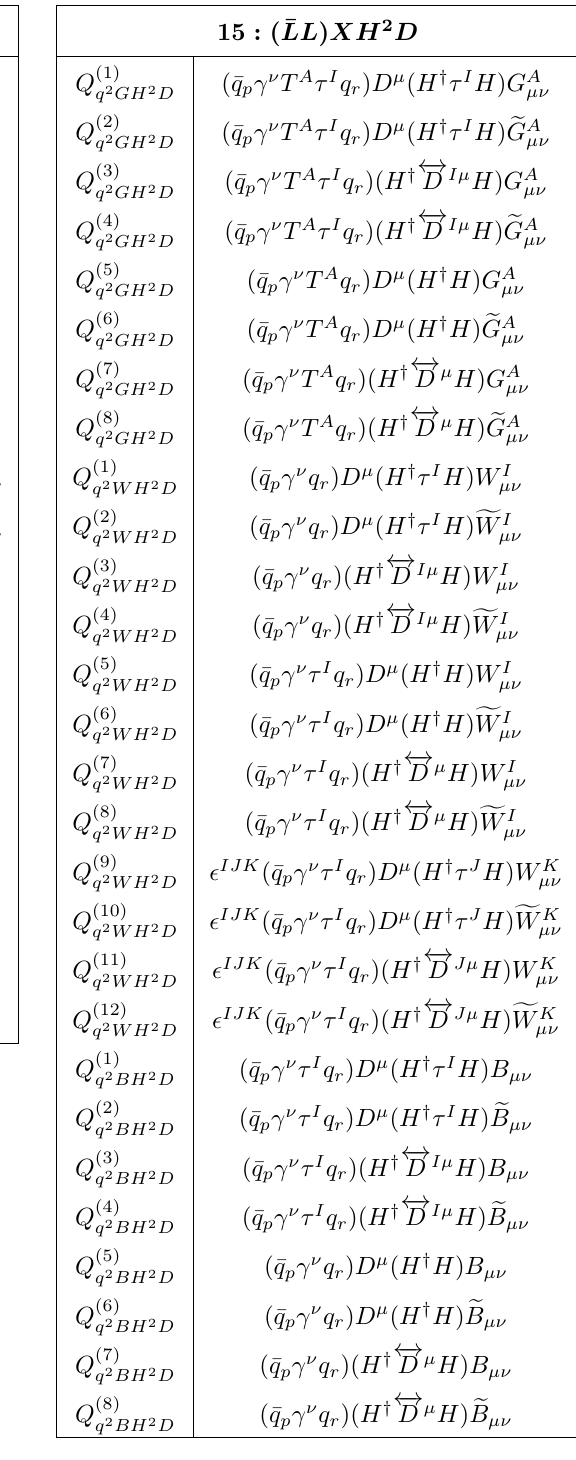
Table 8 . The dimension-eight operators in the SMEFT of class-15 with (cid:12)eld content ((cid:22) LL ) X 2 H . The subscripts p; r are weak-eigenstate